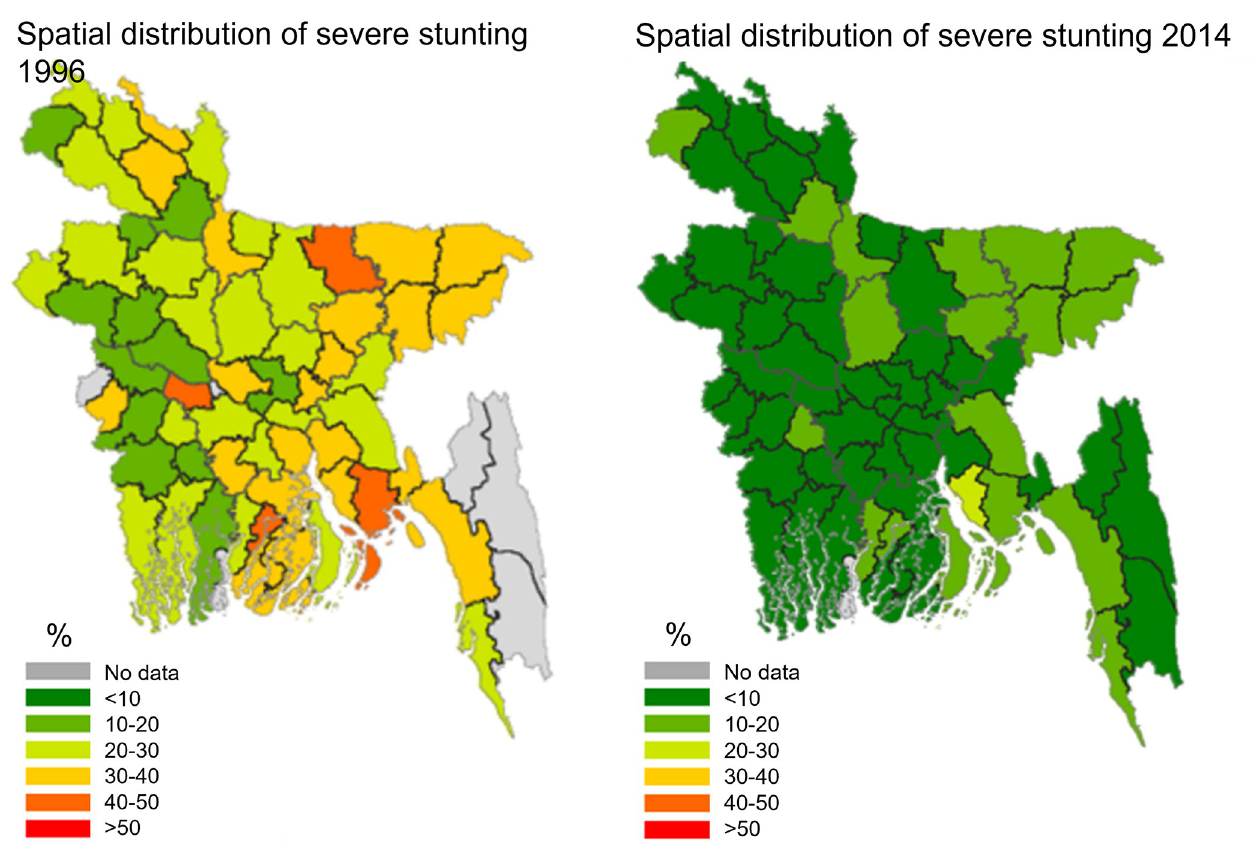
Fig 3. Spatial distribution of severe stunting among under-fives. Source: Own calculations with GRCP software.